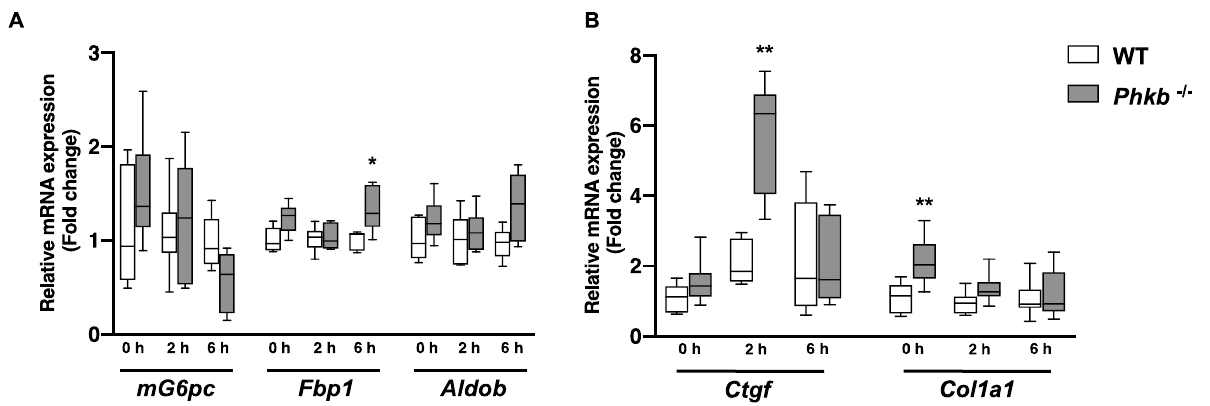
Figure 3. mRNA expression profile of gluconeogenic genes and fibrotic genes in WT and Phkb − / − mice. Quantification of hepatic mRNA for ( A ) gluconeogenic genes ( mG6Pc, Fbp1 , and Aldob ), WT (0 h, n = 5, 2 h, n = 7, and 6 h, n = 5) and Phkb − / − (0 h, n = 11, 2 h, n = 6, and 6 h, n = 5) mice. ( B ) fibrosis related genes ( Ctgf and Col1a1 ), WT (0 h, n = 5, 2 h, n = 7, and 6 h, n = 7) and Phkb − / − (0 h, n = 11, 2 h, n = 6, and 6 h, n = 7) mice. Data represent the mean ± SD. * p < 0.05 and ** p < 0.01. Abbreviations: mG6Pc , mouse Glucose-6-phosphatase- α , Fbp1 , Fructose-bisphosphatase 1, Aldob , Aldolase b. Ctgf , Connective tissue growth factor. Col1a1 , Type I collagen.